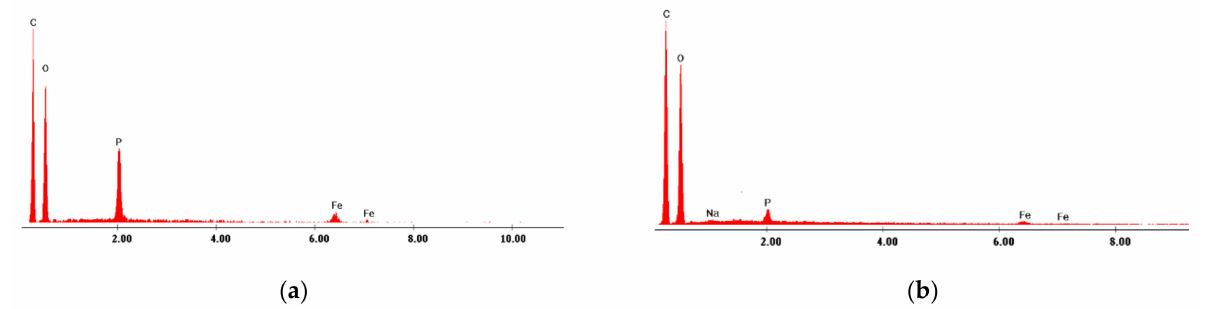
Figure 2. EDX spectrum of materials ( a ) V-DEHPA-Fe and ( b )